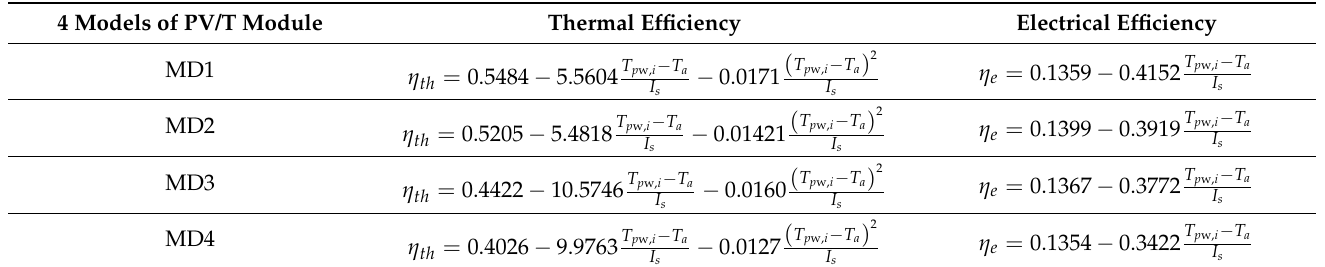
Figure 16. Electrical efficiency of four PV/T module models. Table 4. Thermal and electrical efficiency formula of four PV/T module models.